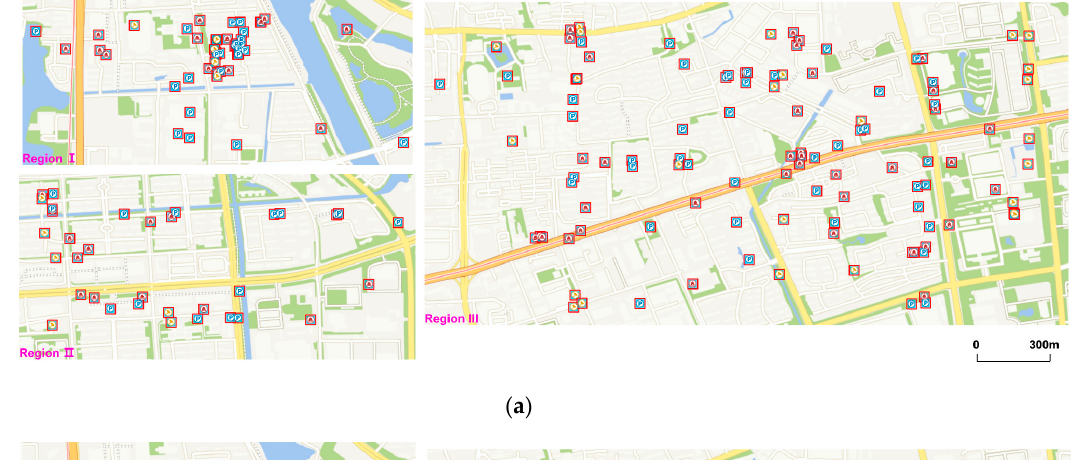
Figure 10. Original points and generalization results at LOD 14. (a) original points at LOD 14; (b) generalization results at LOD 14.